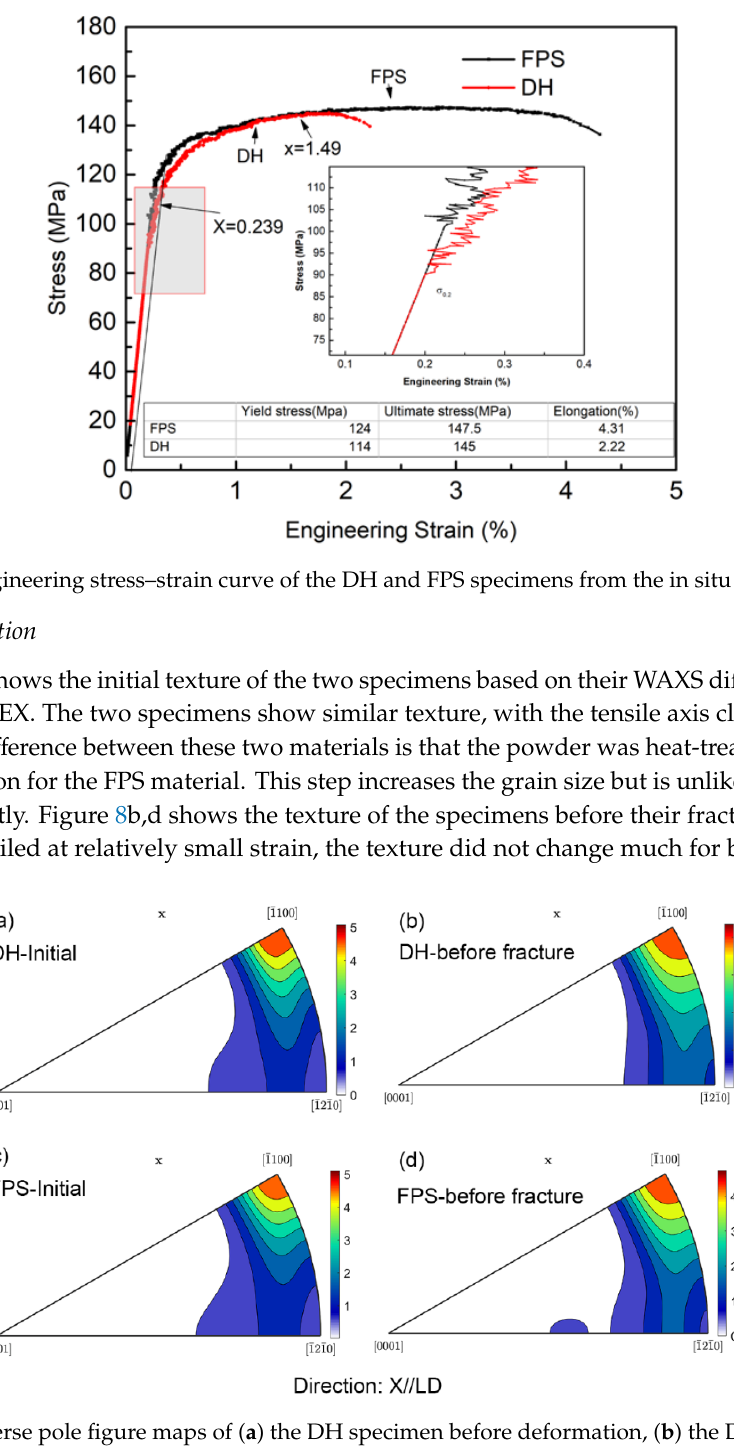
Figure 8. Inverse pole figure maps of ( a ) the DH specimen before deformation, ( b ) the DH specimen before fracture, ( c ) the DH specimen before deformation, and ( d ) the FPS specimen before